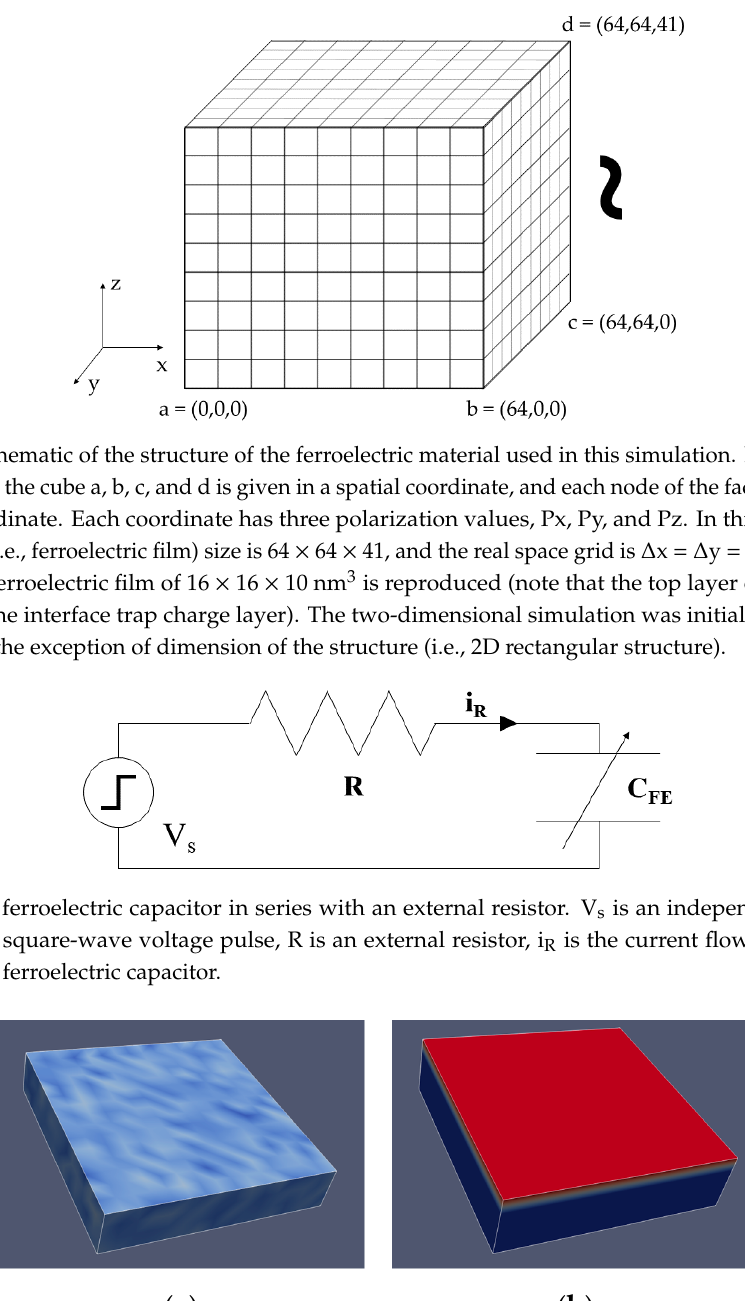
Figure 4. Ferroelectric film in a ferroelectric capacitor at an initial state. ( a ) Ripples in ( a ) represent the